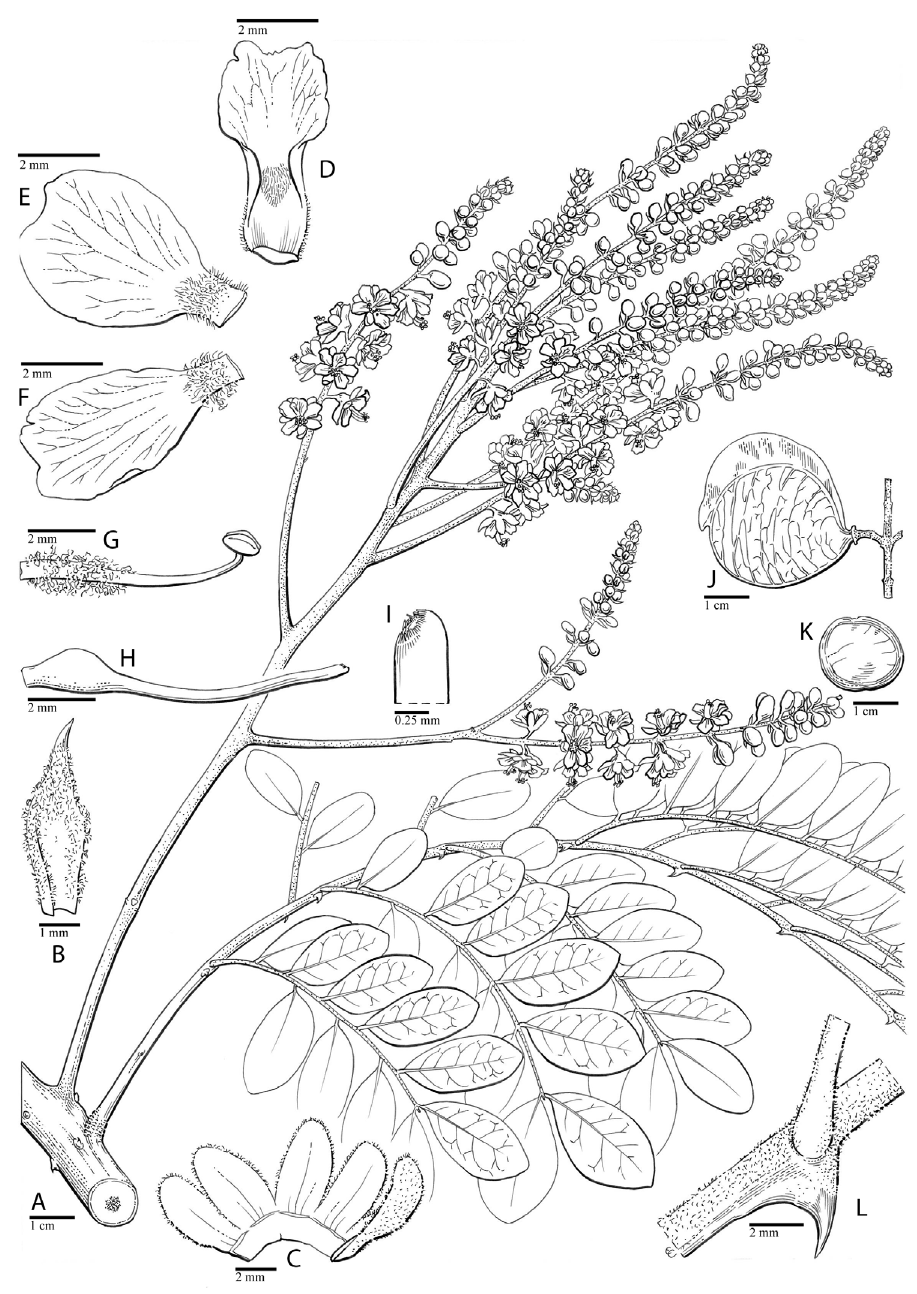
Figure 25. Mezoneuron scortechinii F. Muell. A flowering branch B bract C calyx opened out D median petal E upper lateral petal F lower lateral petal G stamen H gynoecium I stigma J fruit K seed L detail of prickle from leaf. A–I, L from Hoogland 11665 J from Thurtill & Coveny 3880 K from White s.n. 6/1926. Drawn by Eleanor